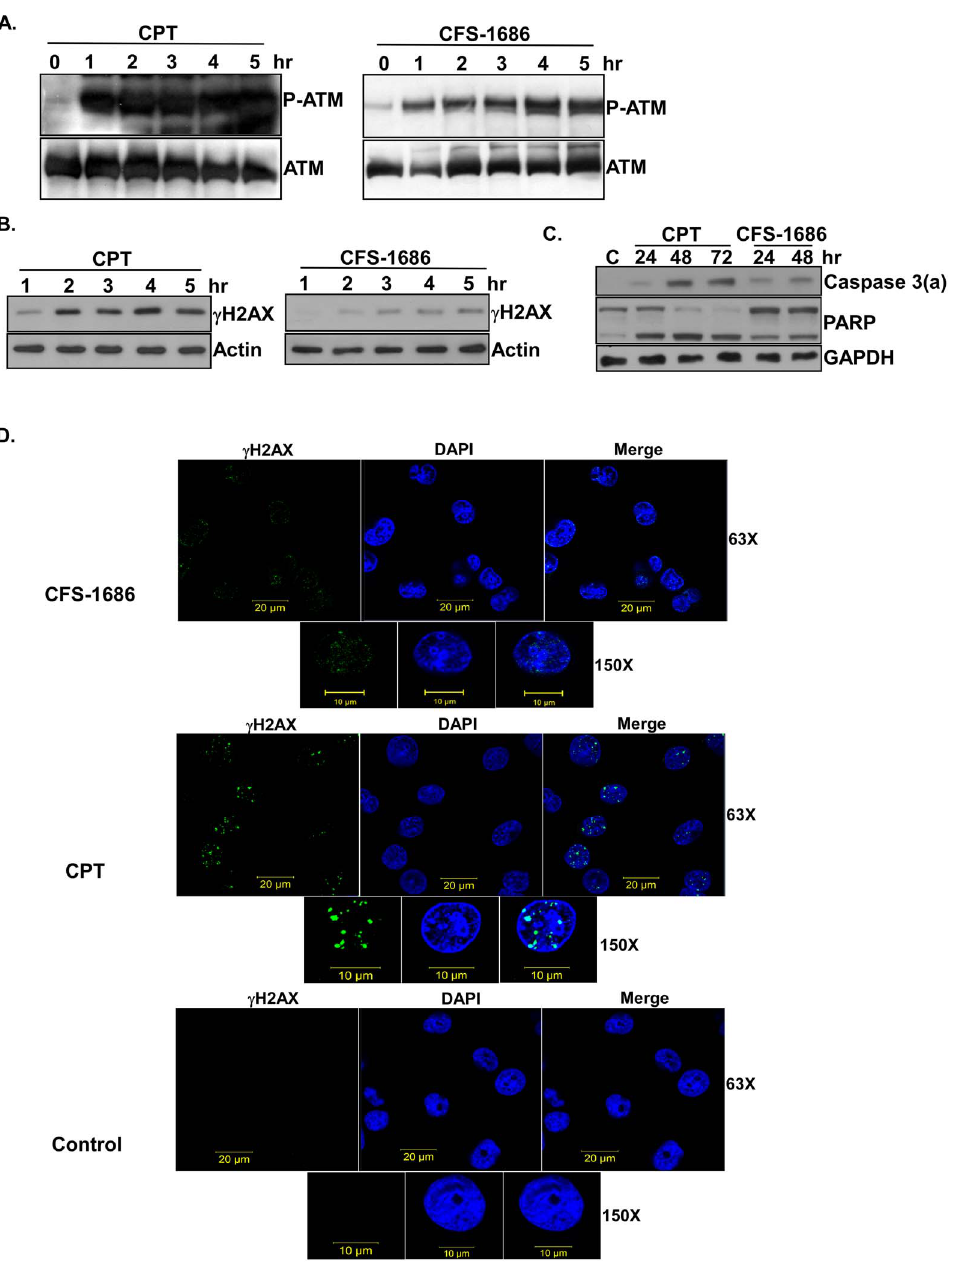
Figure 2. The effects of CFS-1686 or CPT on DNA damage and apoptosis in PC3 cells. (A) Phosphorylation of ATM at Ser1981 was induced by CFS- 1686 or CPT. (B) Increased levels of c H2AX were induced by CFS-1686 or CPT. (C) CFS-1686 or CPTcould activate caspase 3 to cleave PARP. (D) c H2AX foci appeared in cells treated with CFS-1686 or CPT. For immunoblot analysis, cell lysates from PC3 cells treated by CFS-1686 or CPT were assayed over the indicated time courses to detect the phosphorylation of ATM at Ser1981 and c H2AX, the activation of caspase 3 and the degradation of PARP. P-ATM stands for the phosphorylation form of ATM. Caspase 3(a) represents the activation form of caspase 3. Experiments were repeated twice and representative results are shown. For immunofluorescence micrographs of c H2AX, PC3 cells treated by CFS-1686 or CPT for 12 hours were fixed and stained with the antibody for c H2AX and DAPI. Analyses were duplicated and representative immunofluorescence micrographs are shown. c H2AX was shown by green color. DNA was shown by blue color. 63X: 63 fold amplification in the magnitude. 150X: 150 fold amplification in the magnitude.